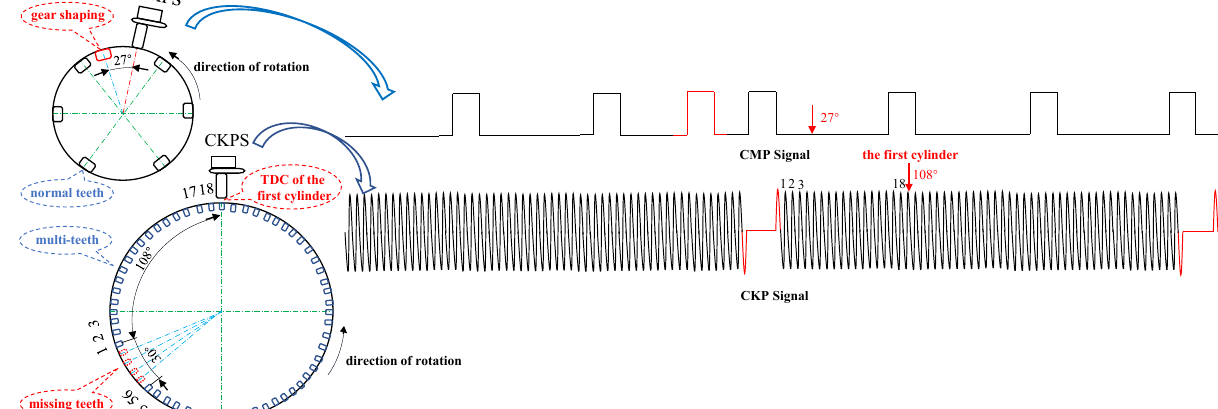
Figure 1. The crankshaft and camshaft joint judgment cylinder diagram. Through the CKP and CMP signals, the ECU determines the top dead center of a cylinder and then makes the cylinder sequence determination. CMPS: Camshaft position sensor. CKPS: Crankshaft position sensor. TDC: Top dead